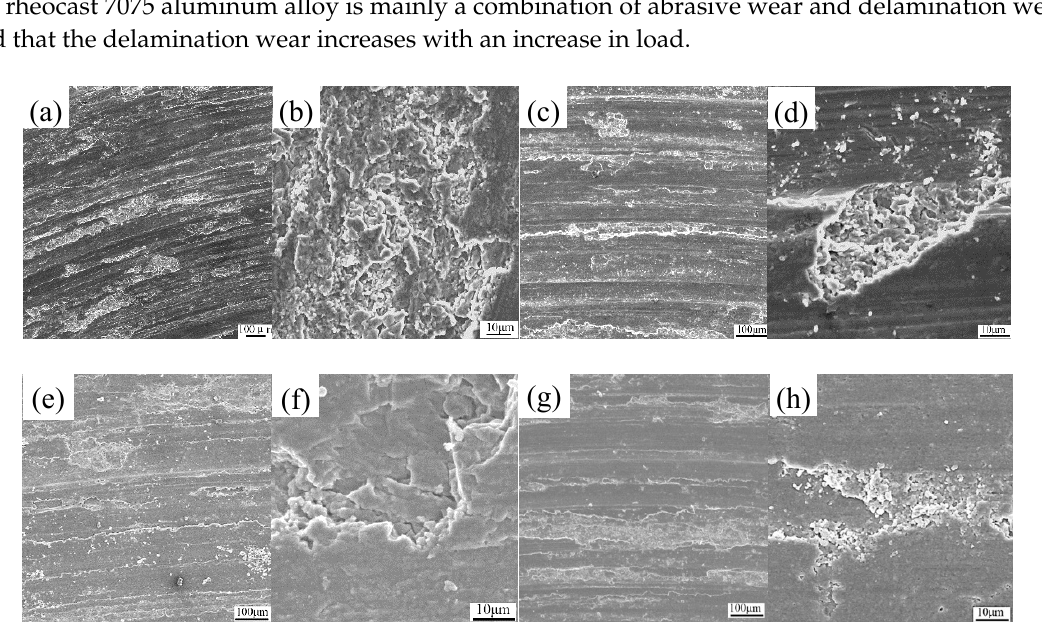
Figure 10. SEM images of rheocast 7075 aluminum alloy tested under di ff erent friction loads: ( a , b ) 30 N, ( c , d ) 60 N, ( e , f ) 90 N, and ( g , h ) 120 N.